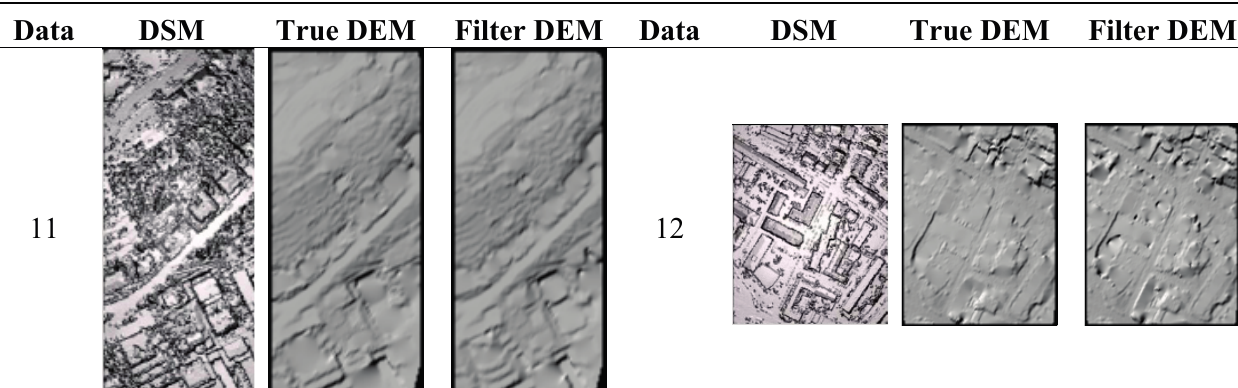
Table 3. DSMs generated from the raw point clouds, DEMs generated from the true ground points, and DEMs generated from the ground points derived by the proposed filter for urban sample